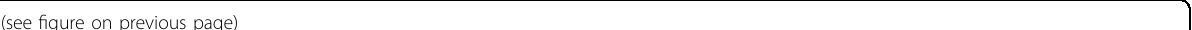
(see fi gure on previous page) Fig. 4 Uridine enhances muscle regeneration in vivo. a Schematic diagram showing the summarized phenotypes in tissue regeneration or repair models. b Schematic diagram for the time course of the mouse muscle cryoinjury and vehicle or uridine treatment. c Left, haematoxylin and eosin (H&E) staining of the skeletal muscle derived from sham mice ( n = 10 mice) and mice treated with vehicle ( n = 10 mice) or uridine ( n = 10 mice) post cryoinjury. Right, quantitative data of mean myo fi ber cross-sectional area (CSA) in the skeletal muscle derived from sham mice and mice treated with vehicle or uridine post cryoinjury. Data are presented as the means ± SEM (two-tailed unpaired Student ’ s t- test). Scale bars, 100 μ m. d Left, Masson staining of the quadriceps femoris derived from sham mice ( n = 9 mice) and injured mice treated with vehicle ( n = 9 mice) or uridine ( n = 9 mice). Right, quantitative data of the fi brotic area. Data are presented as the means ± SEM (two-tailed unpaired Student ’ s t- test). Scale bars, 100 μ m. e ELISA detecting the secretion of proin fl ammatory factors in the serum of sham mice ( n = 20 mice) and mice treated with vehicle ( n = 25 mice) or uridine ( n = 25 mice) post cryoinjury. Data are presented as means ± SEM (two-tailed unpaired Student ’ s t- test). f Grip strength evaluation of the hind limbs of sham mice ( n = 15 mice) and mice treated with vehicle ( n = 15 mice) or uridine ( n = 15 mice) at day 7 post cryoinjury. Data are presented as means ± SEM (two-tailed unpaired Student ’ s t test). g Treadmill distance of sham mice ( n = 15 mice) and mice treated with vehicle ( n = 15 mice) or uridine ( n = 15 mice) at day 7 post cryoinjury. Data are presented as means ± SEM (two-tailed unpaired Student ’ s t- test). h Gene set enrichment analysis showing relative expression levels for downregulated DEGs upon cryoinjury (top) and upregulated DEGs upon cryoinjury (bottom) in the muscle tissues derived from vehicle- or uridine-treated mice. i Top, Venn diagram showing the downregulated genes upon cryoinjury and upregulated genes upon uridine treatment as compared to vehicle treatment. The overlapped genes were de fi ned as “ rescue DEGs (upregulated) ” (left). Ring-heatmap plot showing the relative expression levels of “ rescue DEGs (upregulated) ” in mouse muscle regeneration model (right). Bottom, Venn diagram showing the upregulated genes upon cryoinjury and downregulated genes upon uridine treatment as compared to vehicle treatment. The overlapped genes were de fi ned as “ rescue DEGs (downregulated) ” (left). Ring-heatmap plot showing the relative expression levels of “ rescue DEGs (downregulated) ” in mouse muscle regeneration model (right). The color key from blue to amaranth indicates log 2 (fold change) values from low to high. j Top, GO term and pathway enrichment analysis of “ rescue DEGs (upregulated) ” in mouse muscle regeneration model. Bottom, GO term and pathway enrichment analysis of “ rescue DEGs (downregulated) ” in mouse muscle regeneration model. The color keys from white to red or blue indicate – log 10 ( P -value) from low to